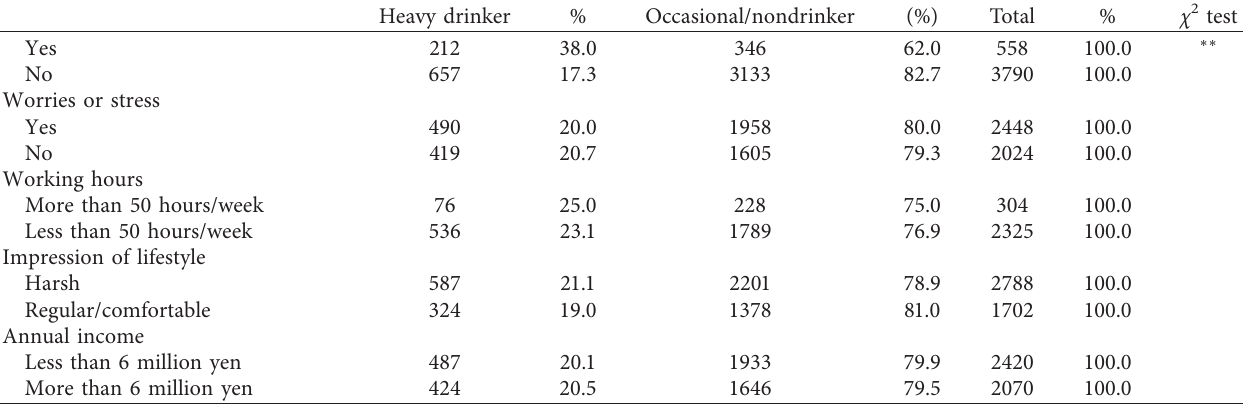
Table 4: Symptoms occurring with the highest frequency according to drinking habits (top ten).